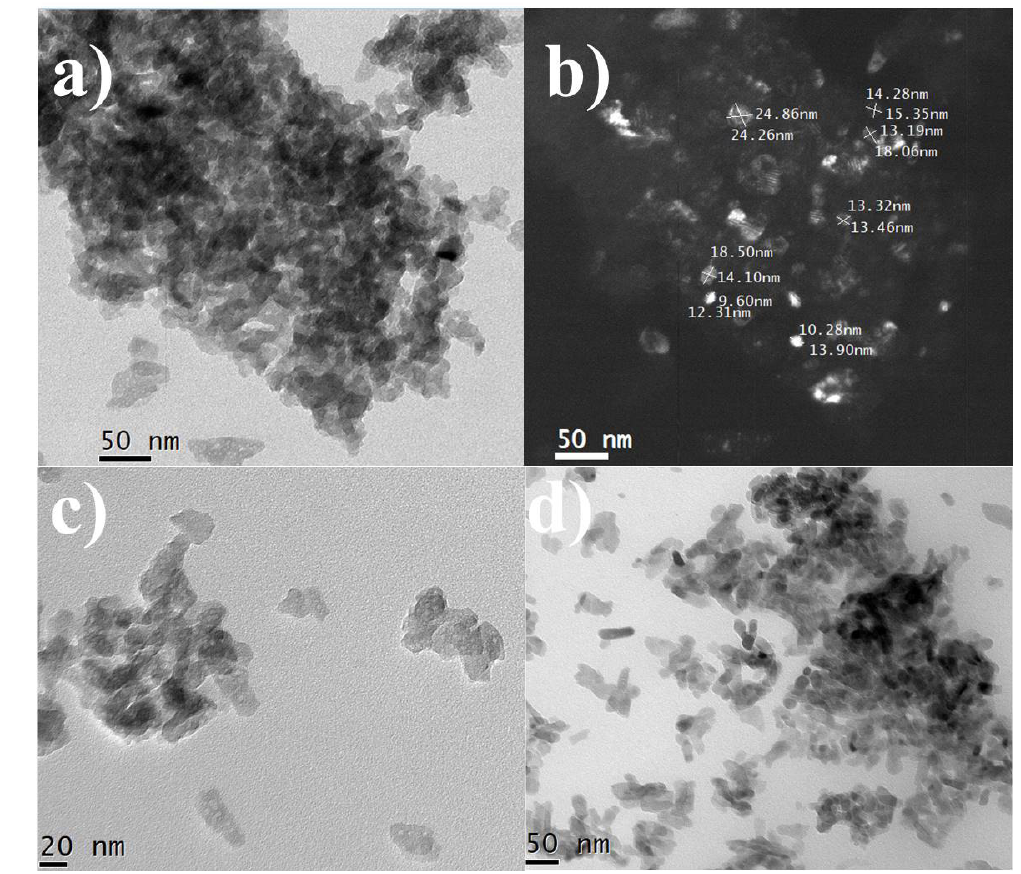
Figure 8. Bright field (a) and dark field (b) pair of the HAS1-600 sample and MET bright field image of samples (c) HAS1-600 and (d)